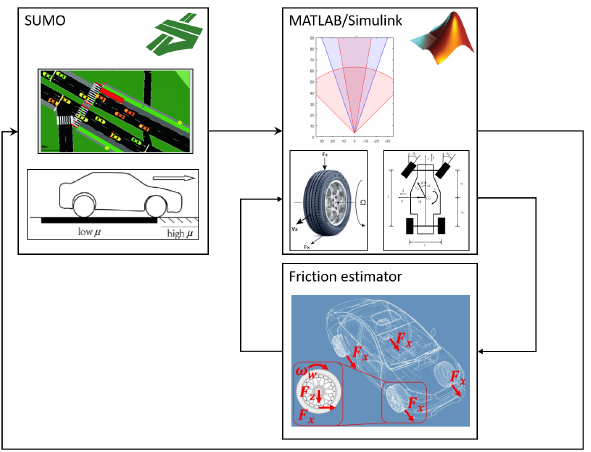
Figure 6. Co-simulation